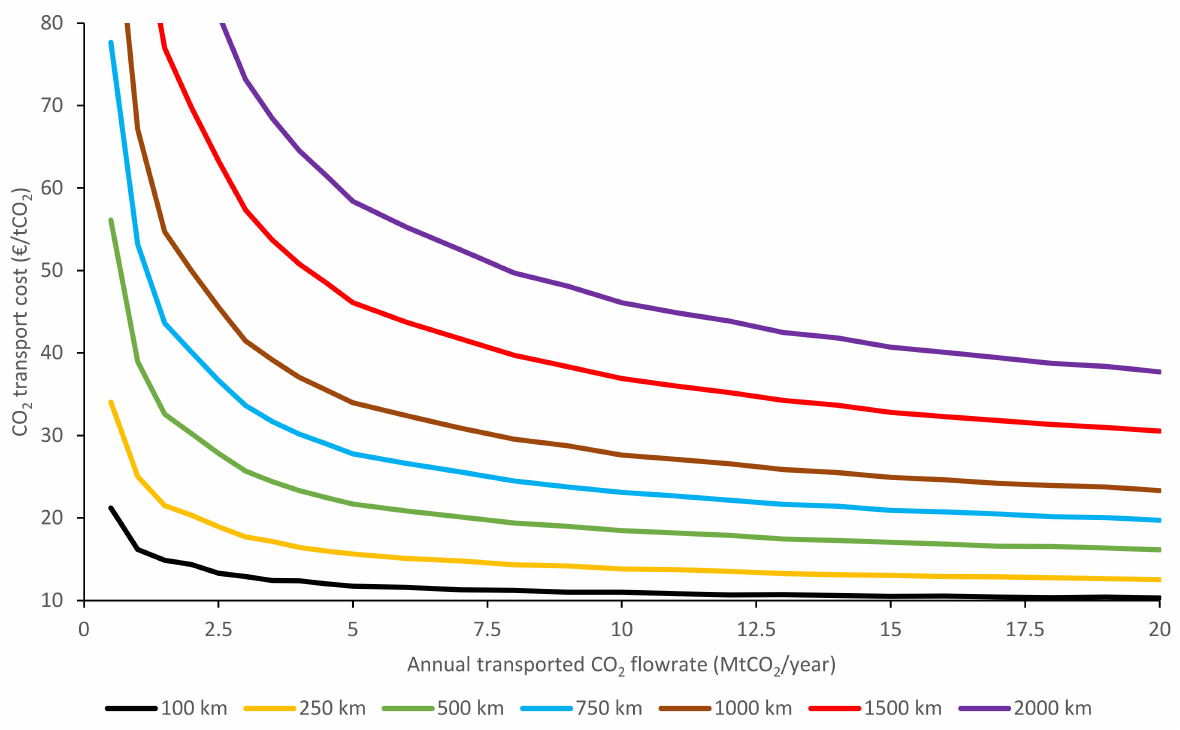
Figure A4. CO 2 conditioning and transport costs as a function of transport distance and annual volume when transporting pure CO 2 between two onshore locations using an onshore pipeline.